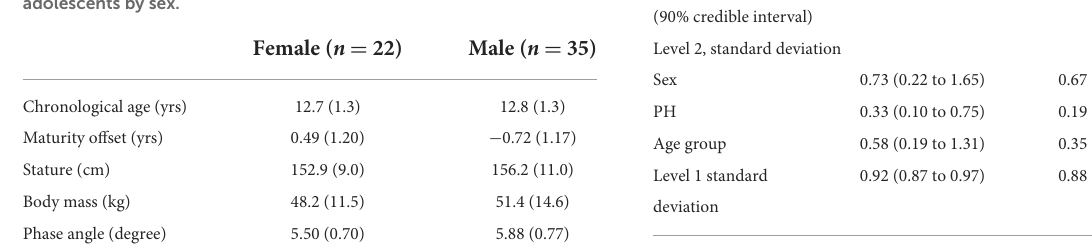
TABLE 3 Descriptive statistics (mean and standard deviation) for adolescents by sex.